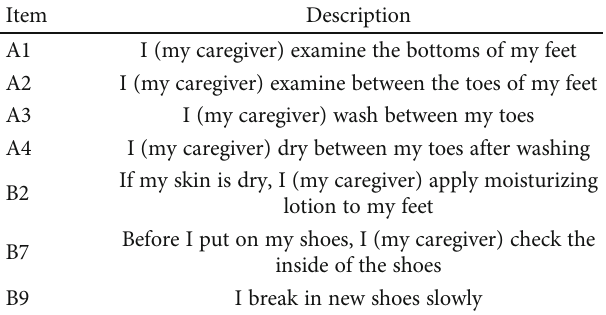
Table 1: Items in the DFSBS